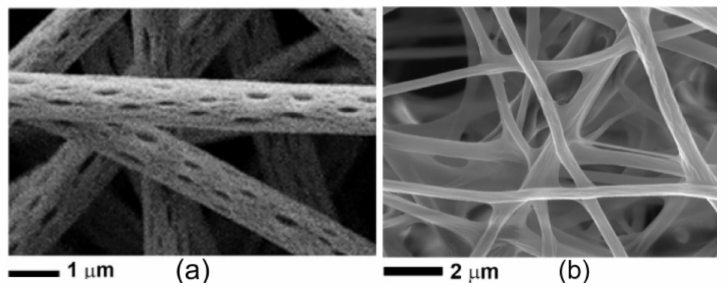
Figure 2. SEM micrographs of PLA-BP fibres uncoated (( a ) magnification scale 1 µ m) and (( b ) magnification scale 2 µ m) coated with chitosan [189]. Reprinted with permission from ref. [189]. 2021 MDPI, Basel, Switzerland,